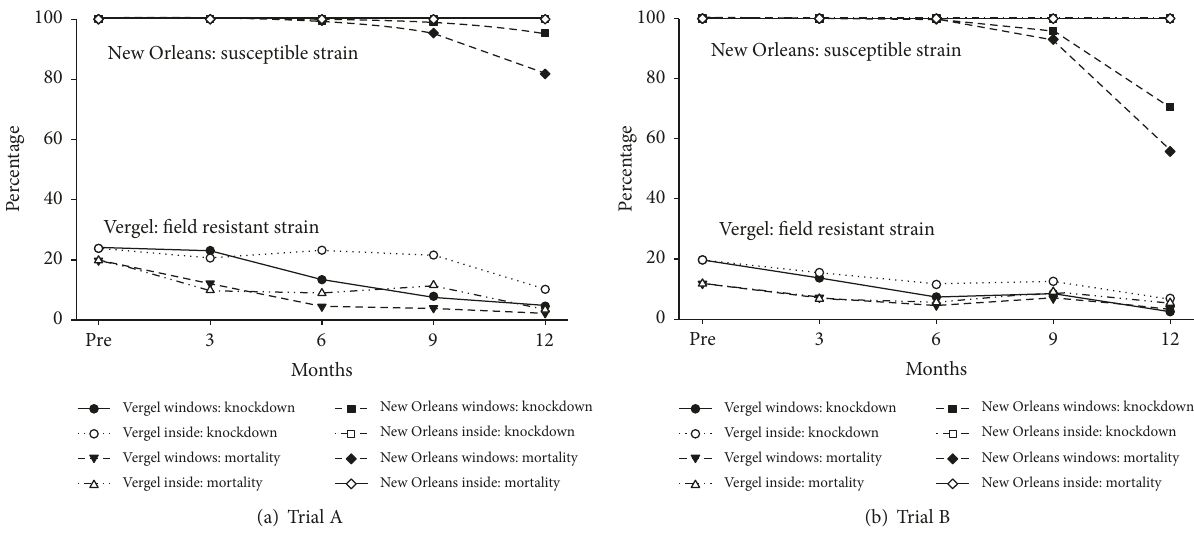
Figure 1: Curtain Toxicity